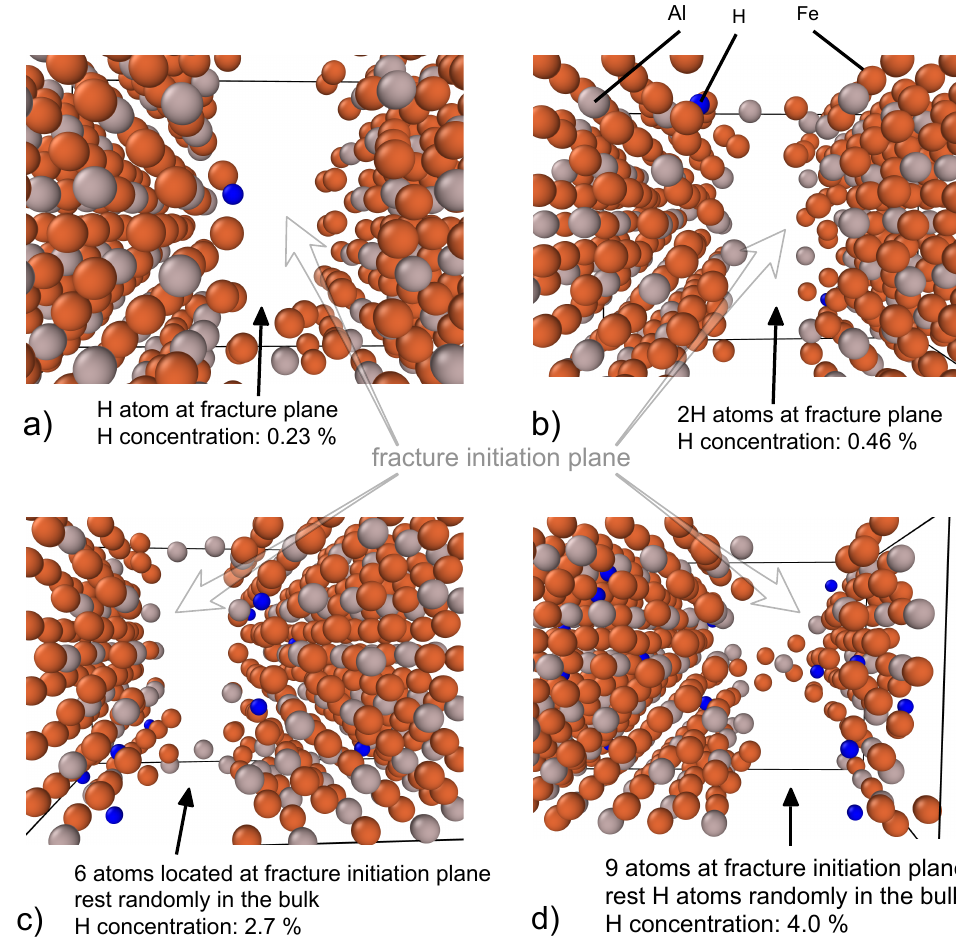
Figure 7. Schematic visualizations of the fracture initiation in Fe 3 Al supercells charged with a different number of hydrogen atoms. In particular, one H atoms per supercell ( a ), two H atoms ( b ), 12 H atoms ( c ), and 18 H atoms ( d